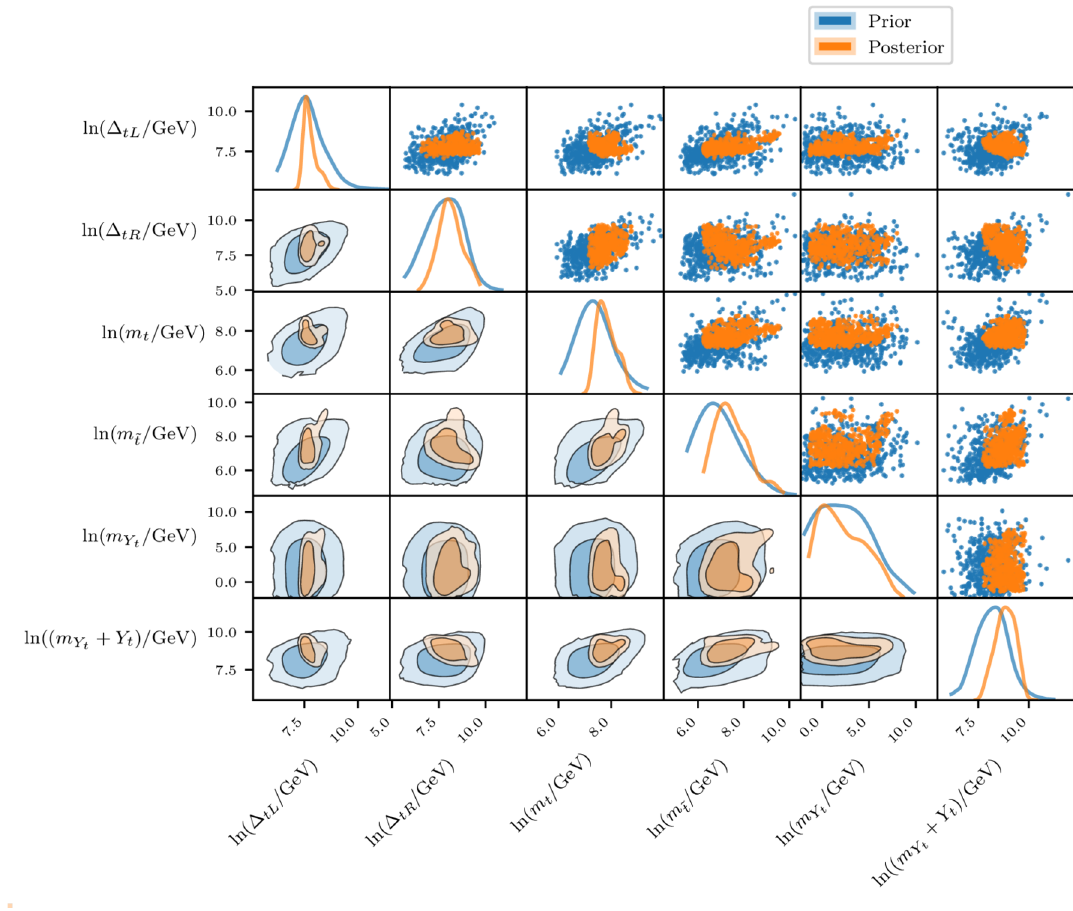
Figure 4. 1D and 2D marginalised priors and posteriors for the top partner parameters in the M4DCHM 5 − 5 − 5